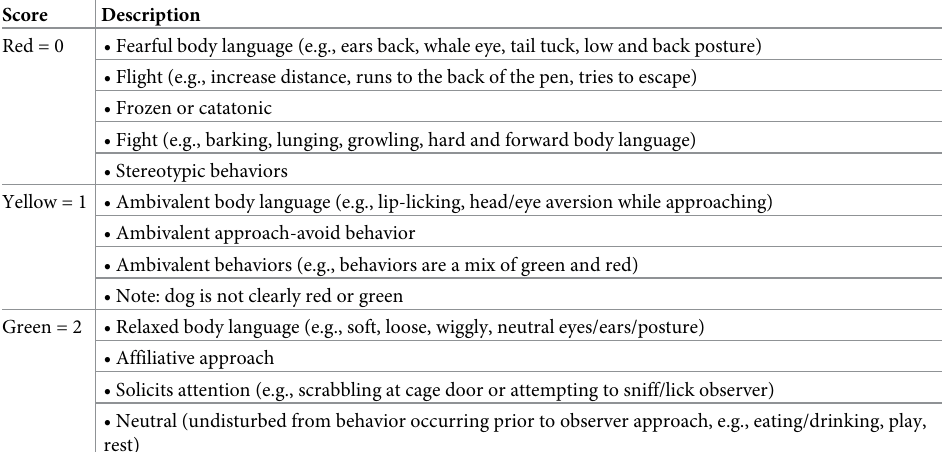
Table 1. Description of Red-Yellow-Green (RYG) scoring system. RYG was used to assess the behavioral reaction of dogs during the three-step approach